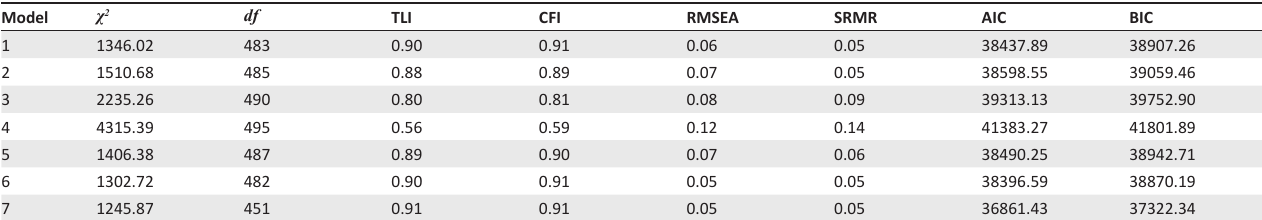
TABLE 2: Fit statistics of competing measurement models. Model